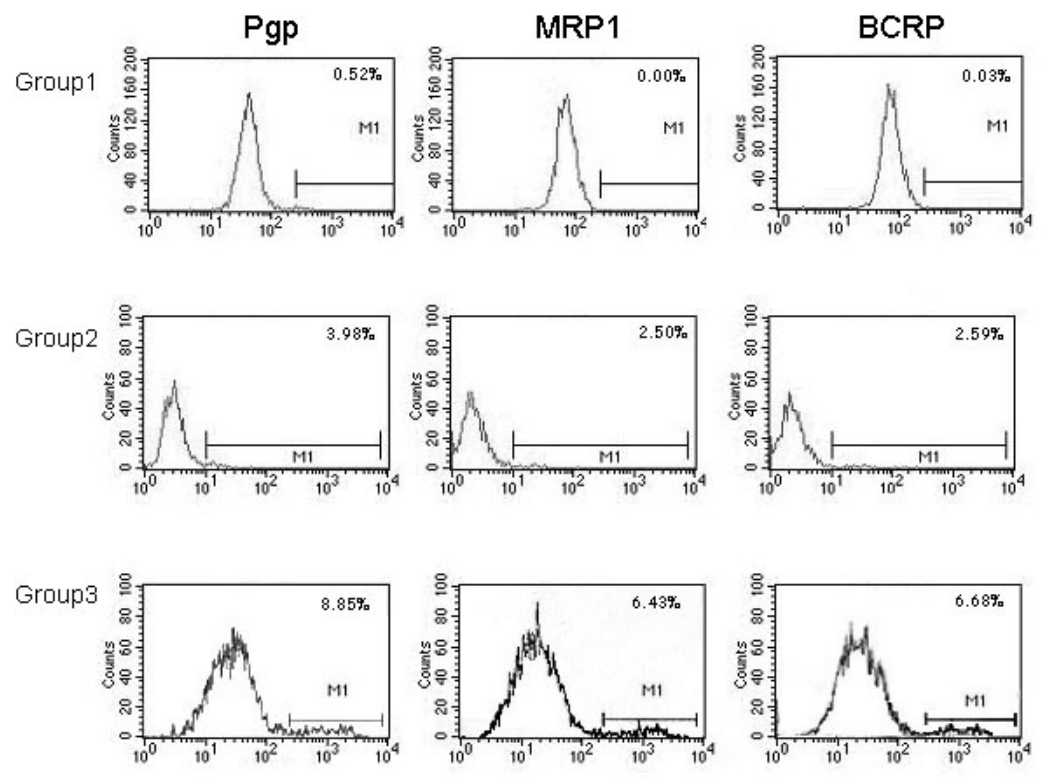
Figure 4. Pgp, MRP1 and BCRP were assayed by flow